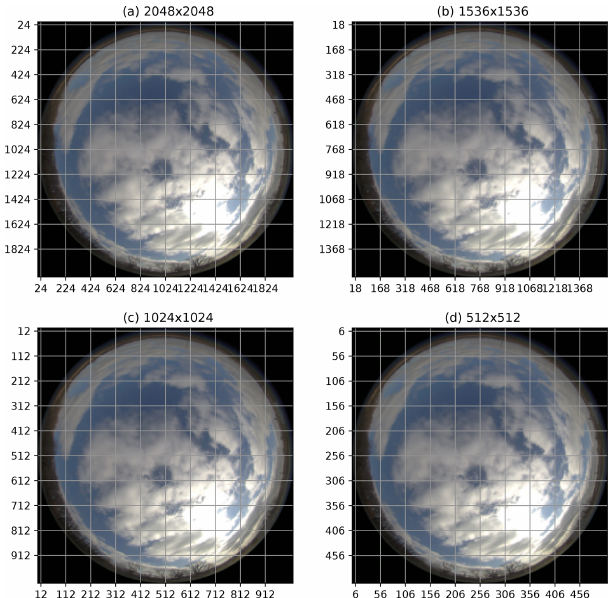
Figure 9. The scheme for testing resolution sensitivity with the Sage camera image obtained on 21 April at 14:06:38 over Lamont, OK. A 10 × 10 block grid with four successively lower resolutions is used for CMV computation to compare the effect of resolution and time interval on the stability of